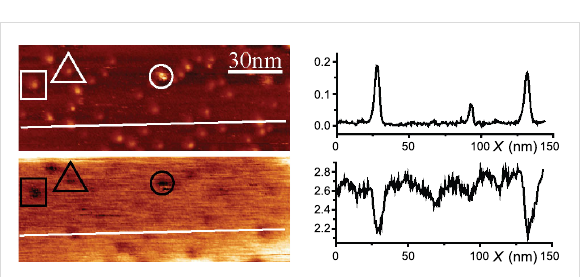
Figure 3: Upper image: topography and lower image: Kelvin map of a KBr terrace with a higher coverage. Imaging conditions: Δ f = − 20 Hz, A = 2 nm. The profiles correspond to the white lines drawn on the images.